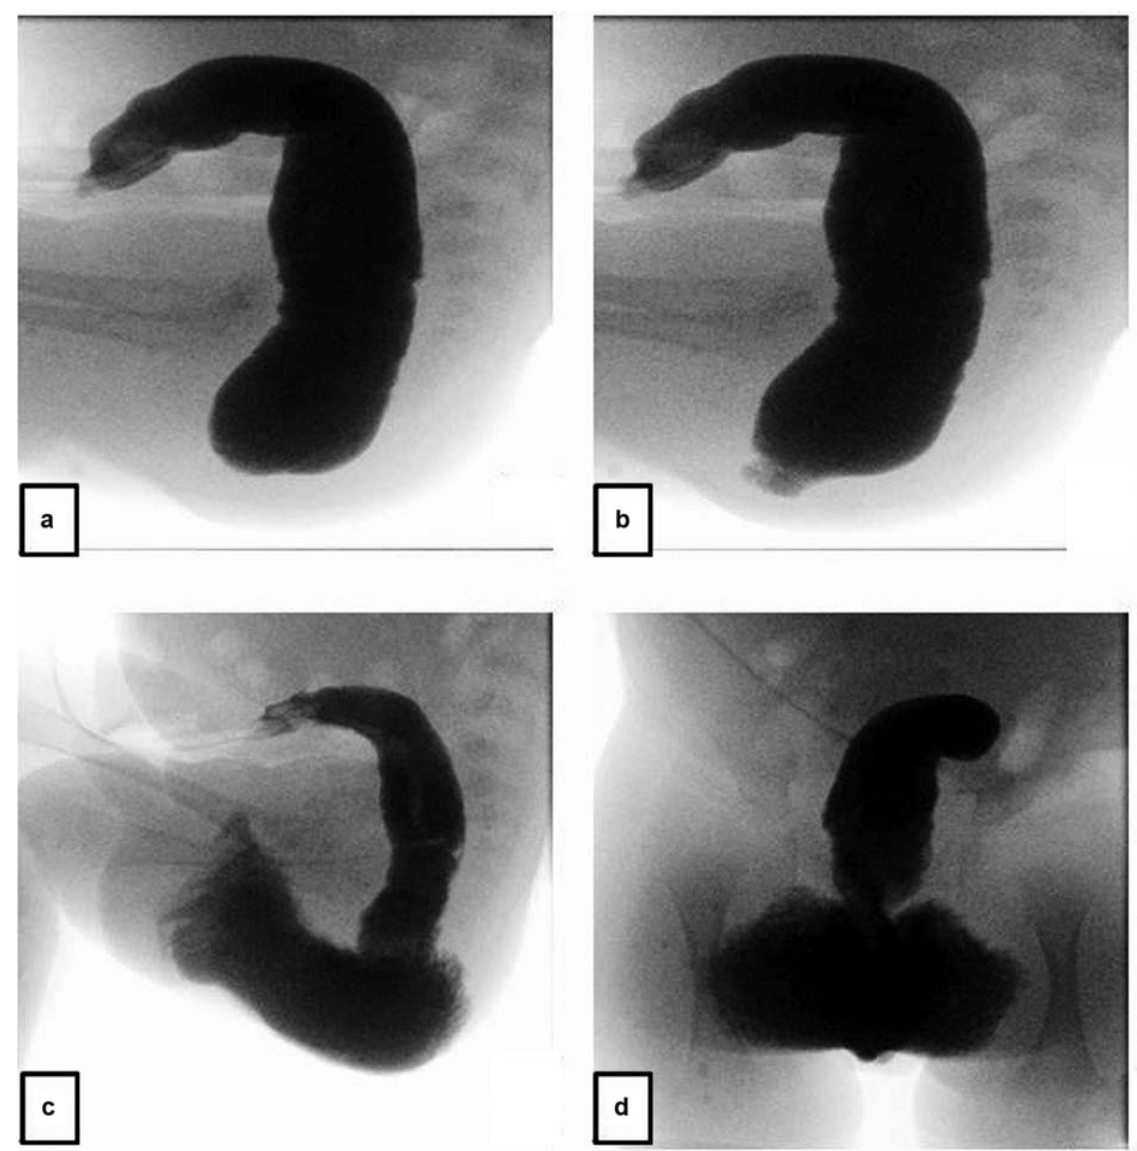
Fig. 3 High-pressure distal colostogram (case 2). ( a ) Lateral view: opaci fi cation of the distal colon with convexity of distal rectal pouch. No rectourinary fi stula is demonstrated. ( b ) Rectal pouch perforation with contrast extravasation into the perineum. ( c ) Lateral view: progressive perineal contrast extravasation extending intothe scrotum. ( d ) Anteroposterior view: progressive perineal contrast extravasationextending into the